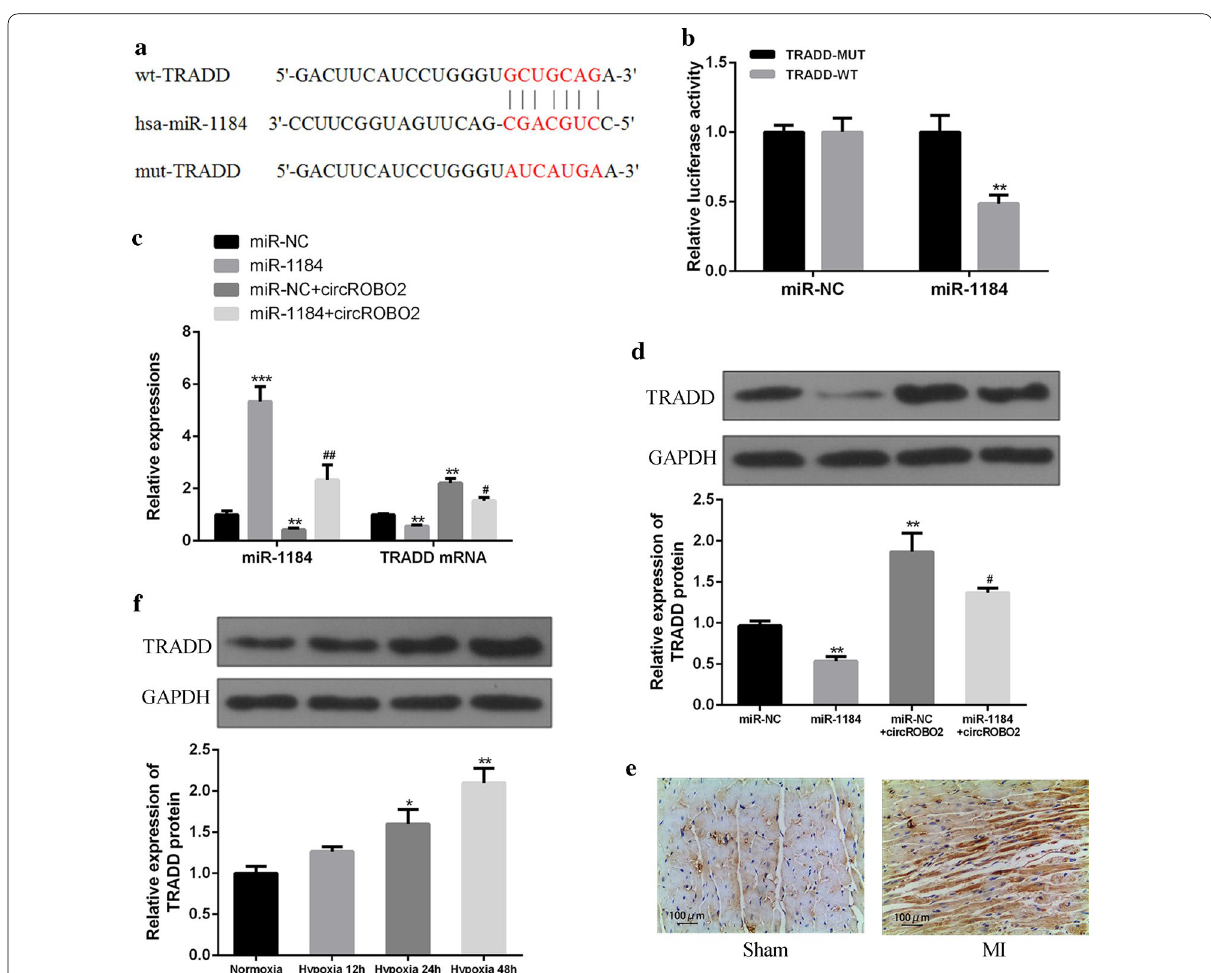
Fig. 3 CircROBO2 up‑regulated the expression of TRADD by sponging miR‑1184. a Putative binding sites for miR‑1184 and TRADD3 ′ ‑UTR. b Analysis of luciferase activity of PGL‑miR‑1184 in HEK293 cells by co‑transfecting withTRADD‑3 ′ ‑UTR‑WT or TRADD‑3 ′ ‑UTR‑Mut vector. The experiments were repeated three times. P < 0.05, ** P < 0.01, *** P < 0.001. c TRADD mRNA expression levels were detected by co‑transfecting miR‑1184 mimics or miR‑NC, circROBO2 vector or control vector in primary cardiomyocytes. The experiments were repeated three times. P < 0.05, ** P < 0.01, *** P < 0.001. d Expression levels of TRADD protein in primary myocardial cells after co‑transfecting with miR‑1184 mimics, miR‑NC vector or miR‑1184 circROBO2. The experiments were repeated three times. e IHC analysis of caspase3 in myocardium form sham and MI group. f + Expression levels of TRADD protein in cardiomyocytes of mice exposed to normoxic or hypoxic conditions (12, 24 and 48 h). There mice were used for this experiment. * vs control group, # vs circROBO2 group. ** P < 0.01, ## P < 0.01